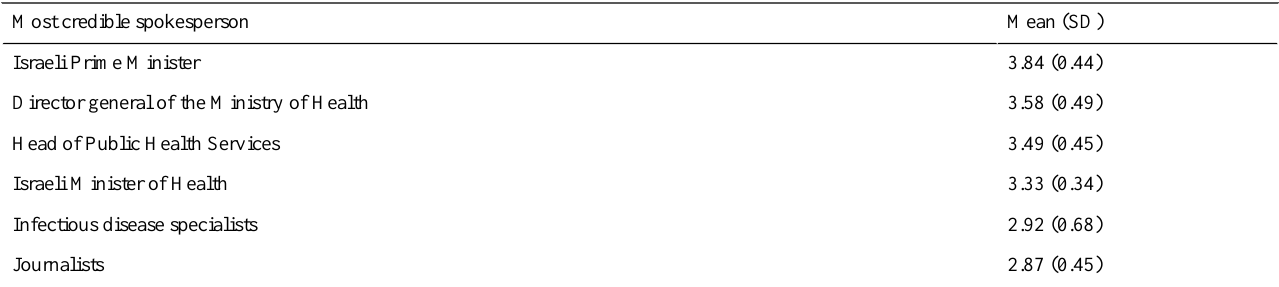
Table 4. The relationships between the six most credible spokespersons and the attitudes toward crisis management using an ANOVA model